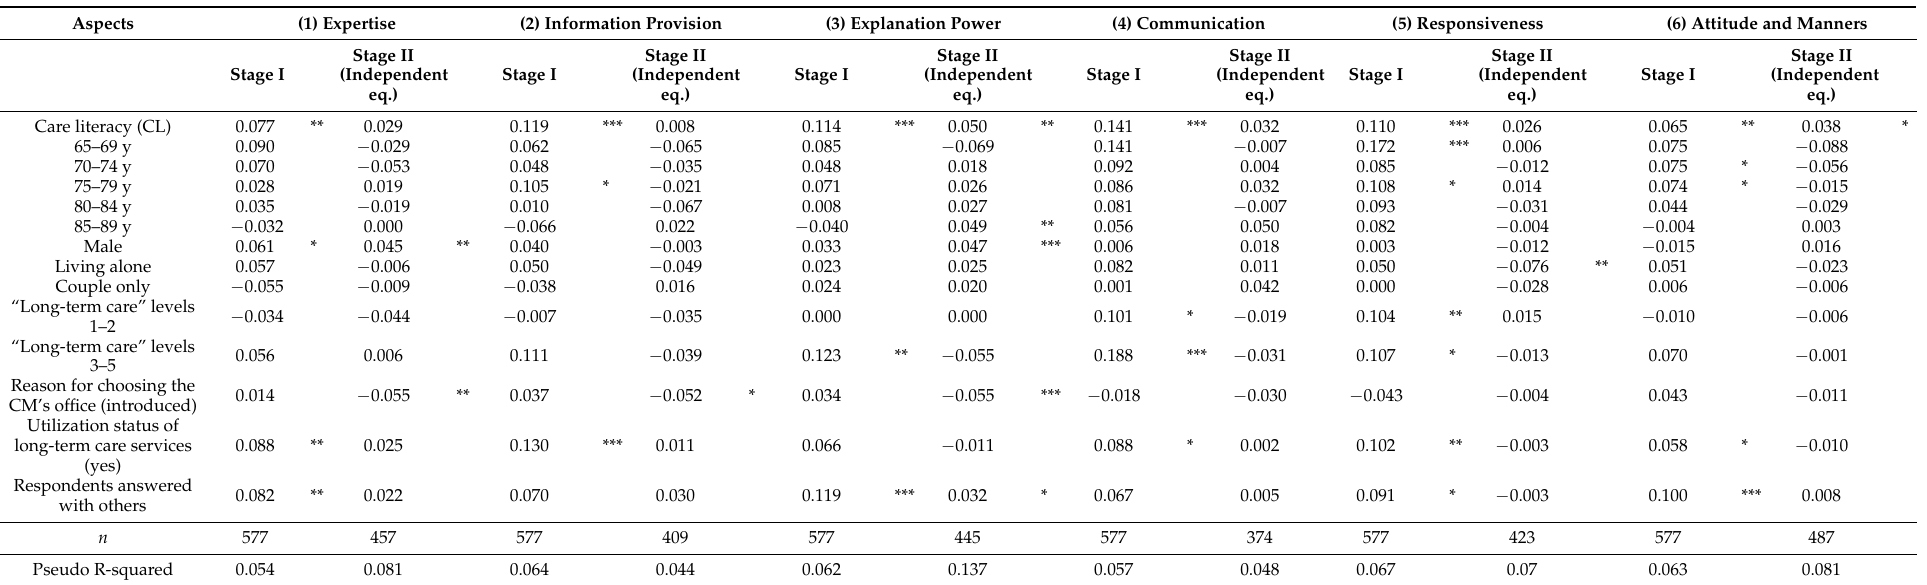
Table 7. Marginal effects of CL and other covariates on satisfaction with CMs estimated by probit